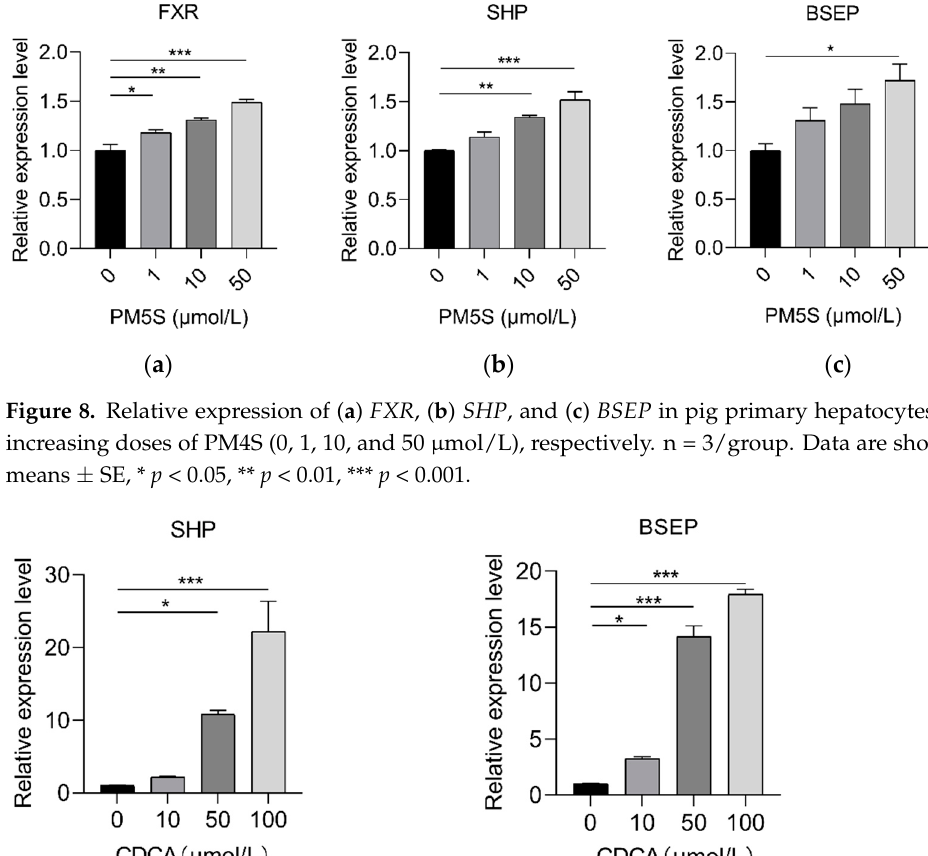
Figure 7. Relative expression of ( a ) FXR , ( b ) SHP , and ( c ) FGF19 in pig primary hepatocytes with an increasing dose of PM4S, respectively. n = 3/group. Data are shown as means ± SE, * p < 0.05, ** p < 0.01, *** p < 0.001.